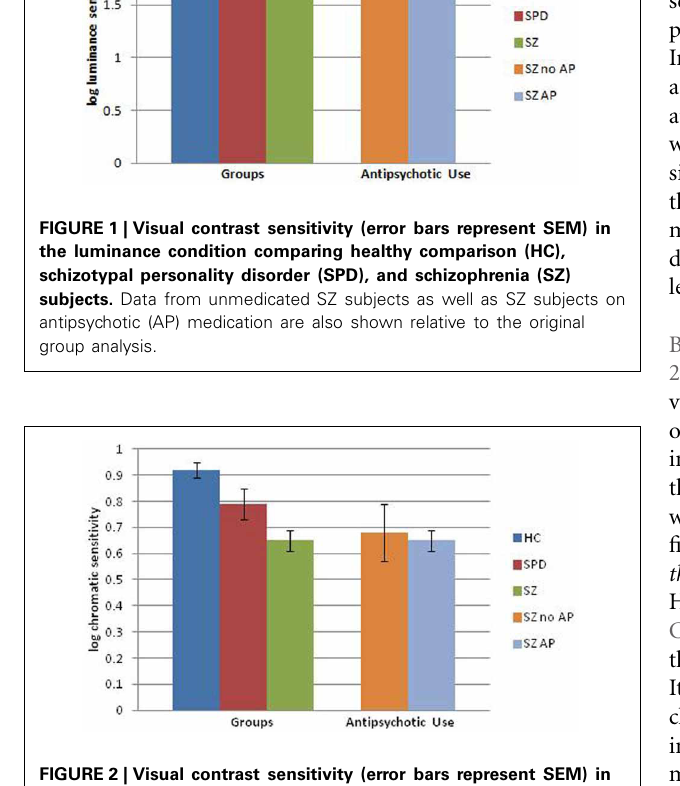
FIGURE 2 | Visual contrast sensitivity (error bars represent SEM) in the chromatic condition comparing healthy comparison (HC), schizotypal personality disorder (SPD), and schizophrenia (SZ) subjects. Data from unmedicated SZ subjects as well as SZ subjects on an antipsychotic (AP) medication are also shown relative to the original group